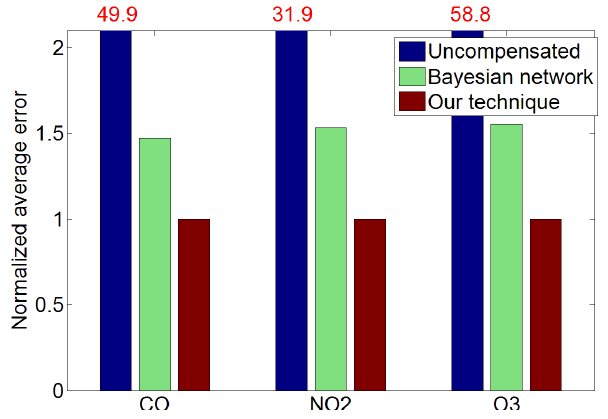
Figure 8. The data recovery results of various techniques for the drifted data.